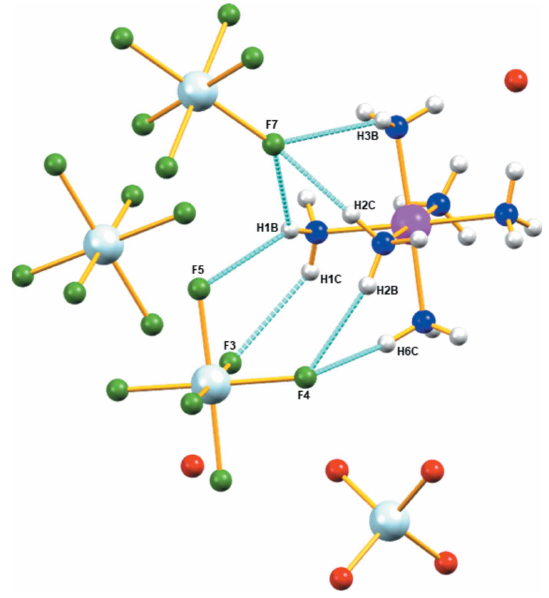
Figure 3 Detail of the hydrogen bonding (blue dotted lines) in ( I ). Atom colors as in Fig. 2.